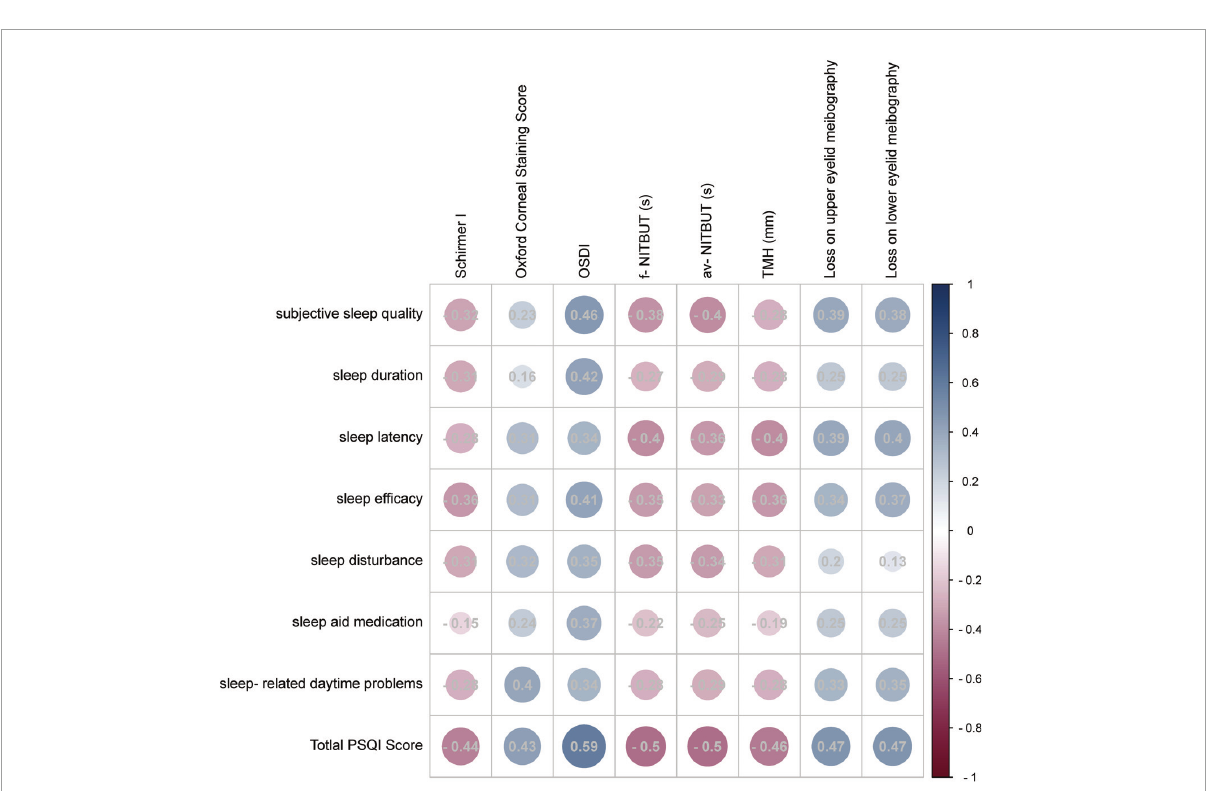
FIGURE3 Correlation matrix of the subscales of PSQI and DED-related parameters. The circle size reflected the Pearson R -value, and detailed Pearson’s R -values were recorded in the circles. The color reflected the correlation coefficient and most red reflected − 1 while most blue reflected